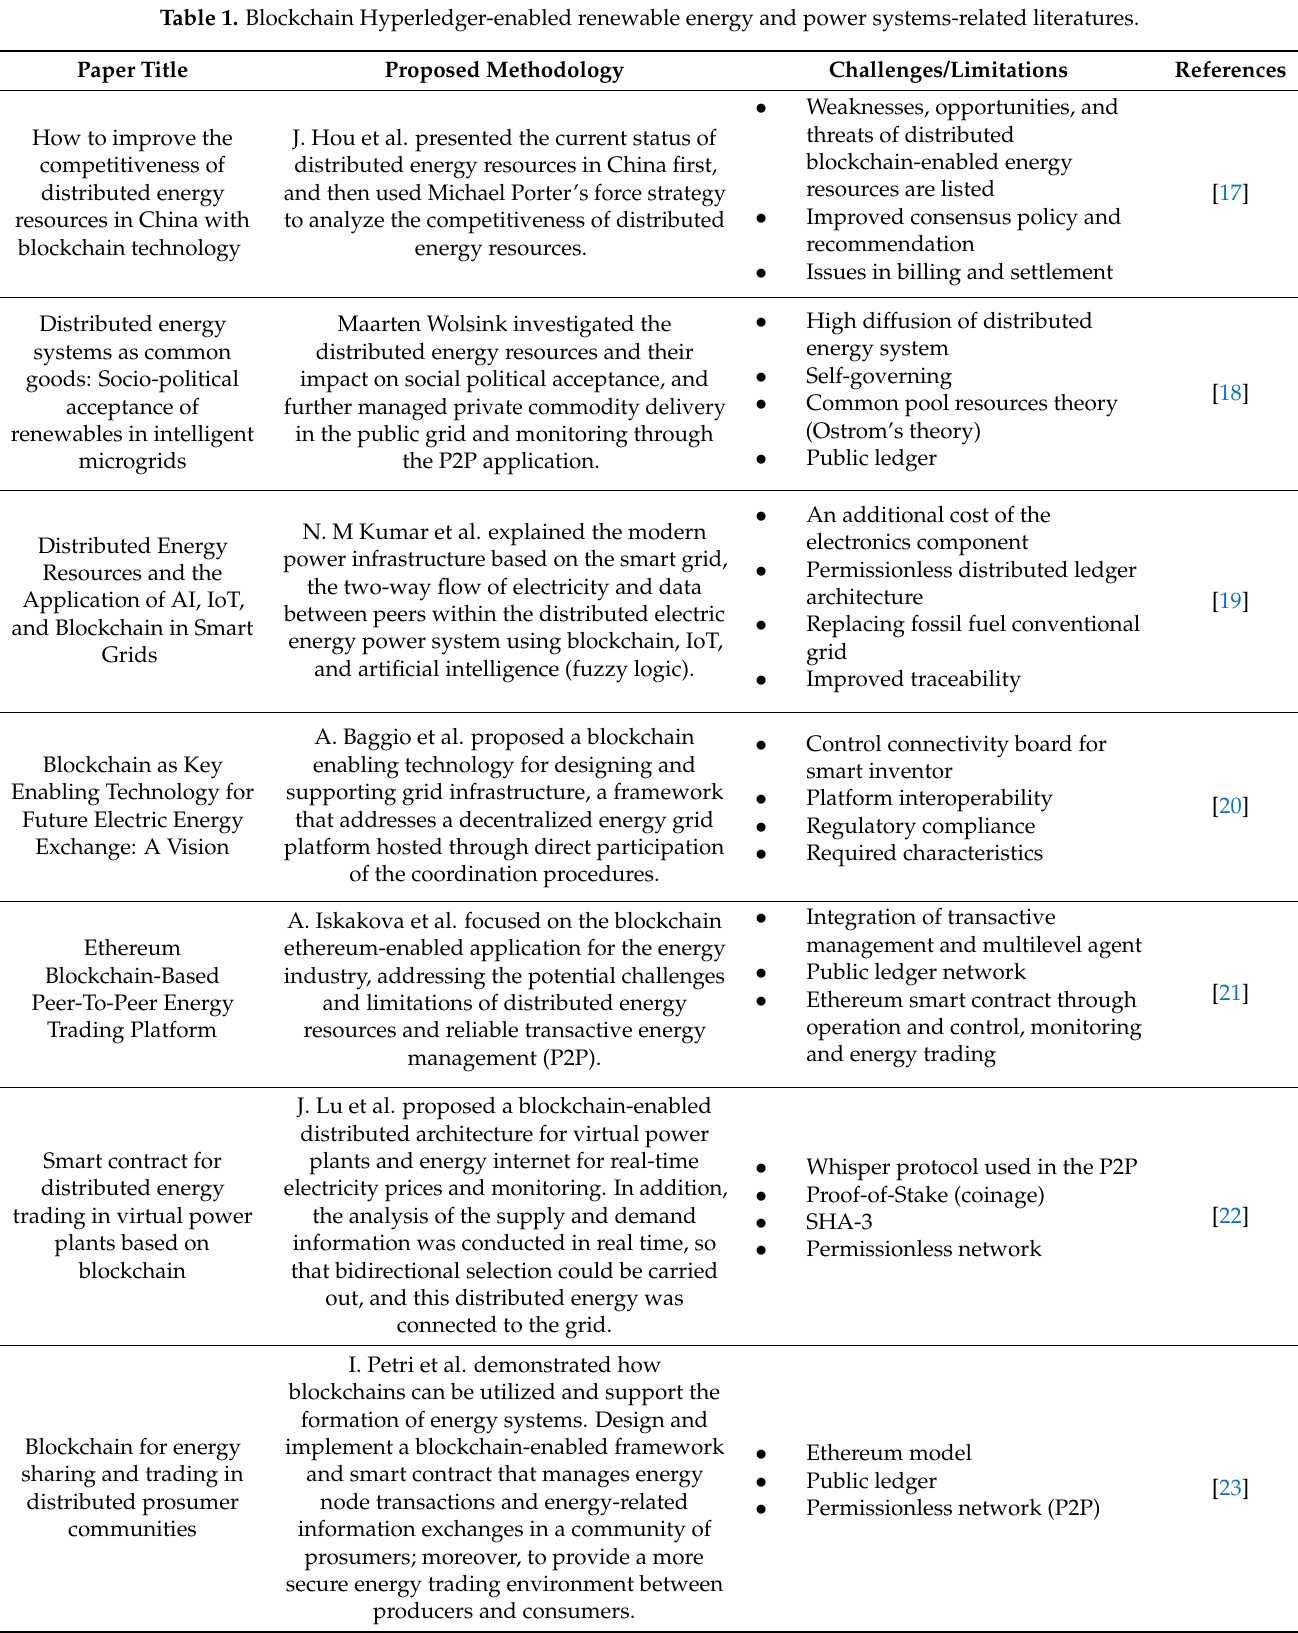
Table 1. Blockchain Hyperledger-enabled renewable energy and power systems-related